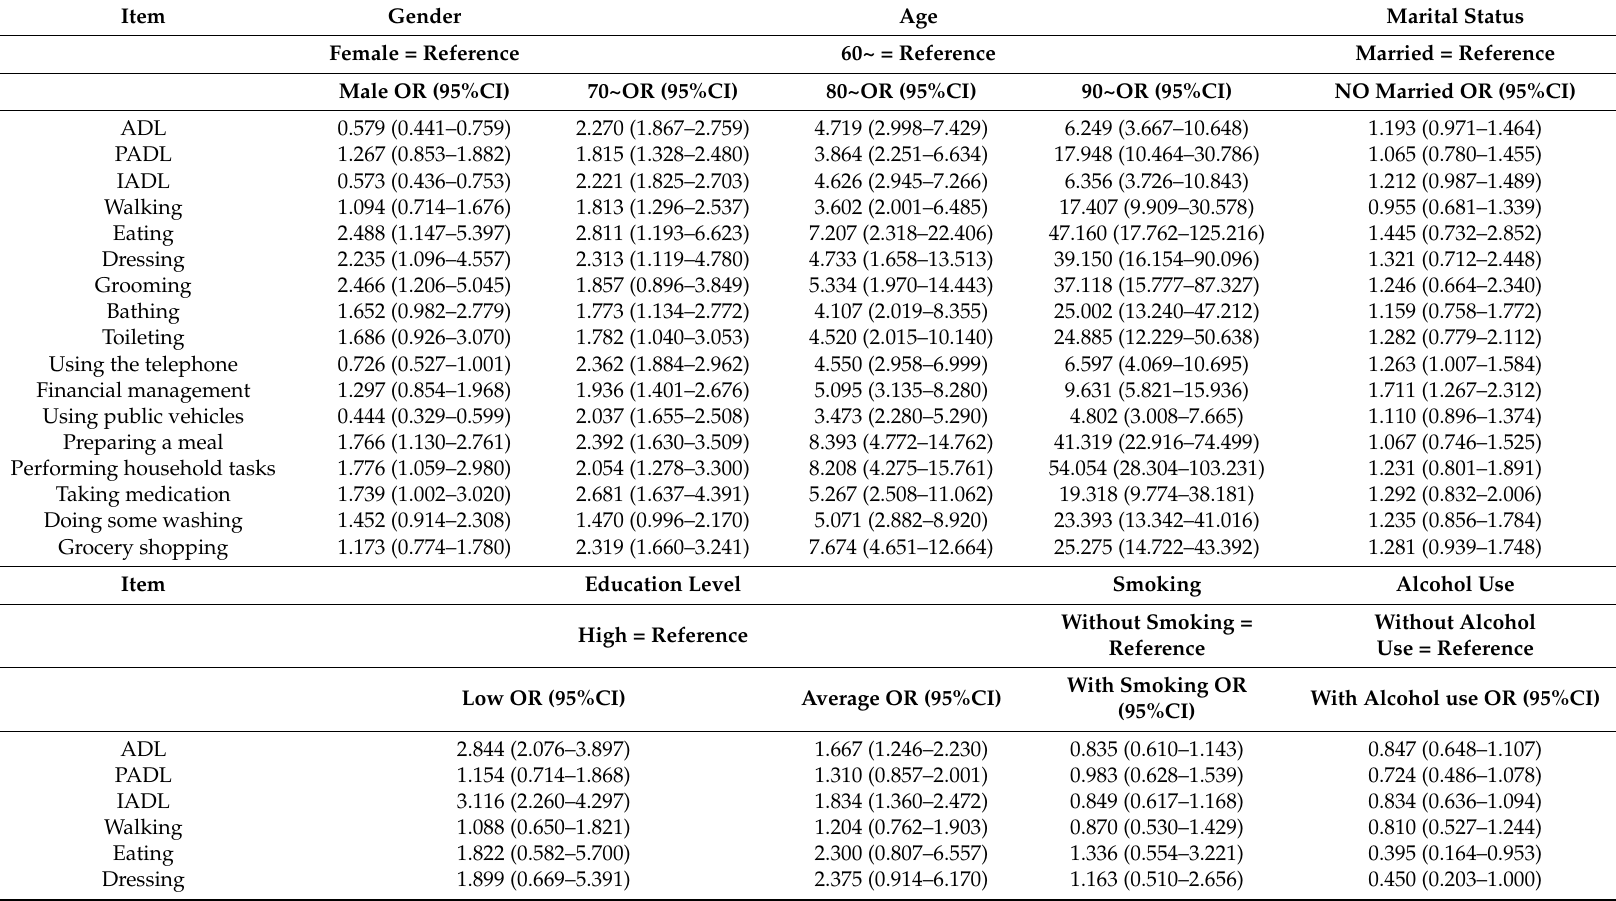
Table 3. Association among gender, age, marital status, education, smoking, alcohol use, chronic disease, metabolic syndrome, and disability; Odds Ratios (OR